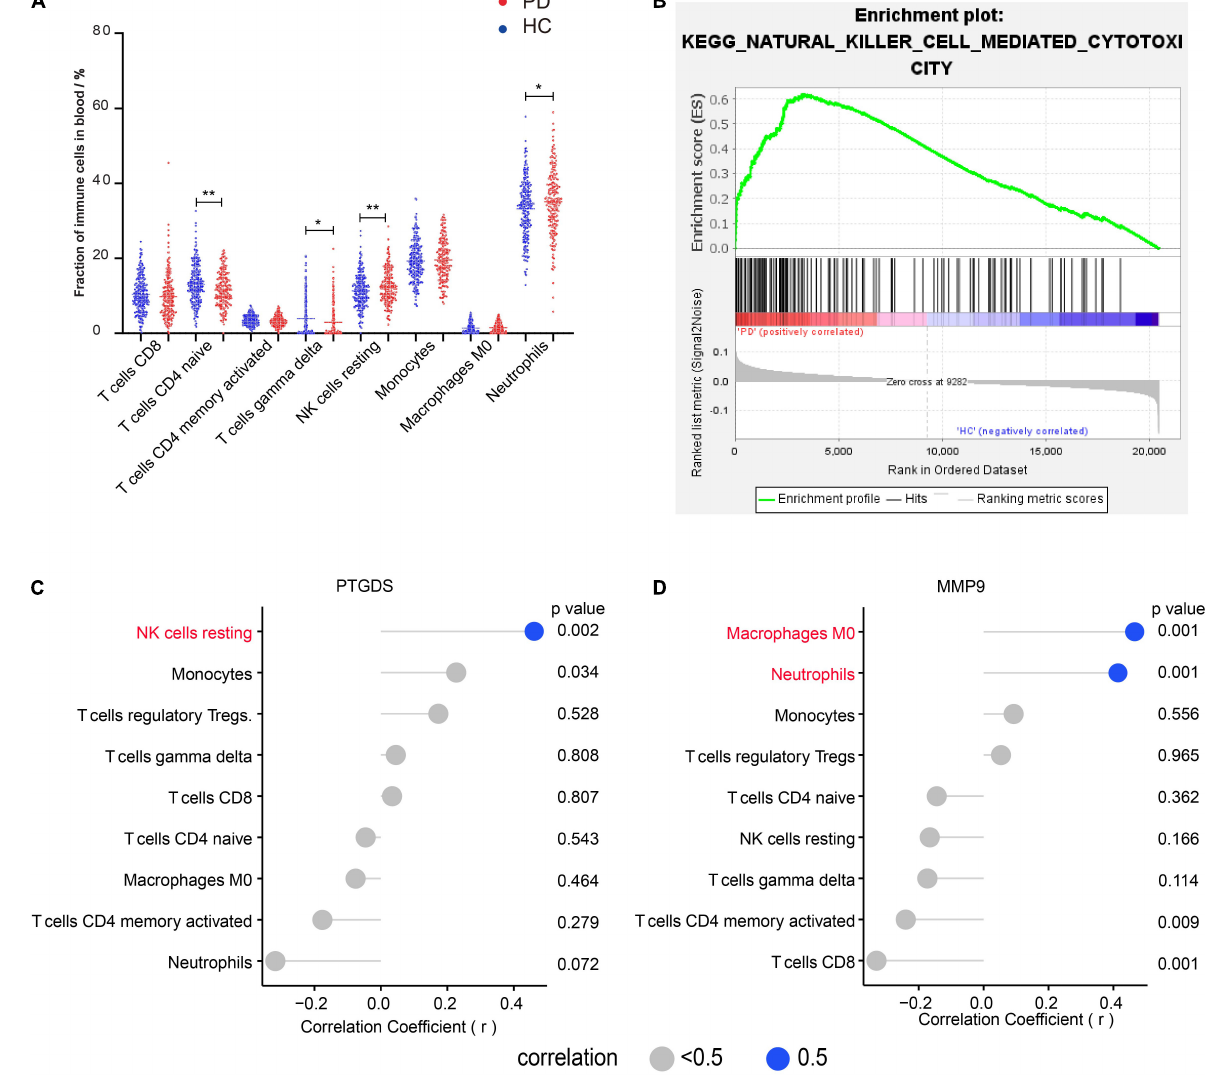
DEGs and naïve CD4 T cells and gamma delta T cells ( Supplementary Figure 1B